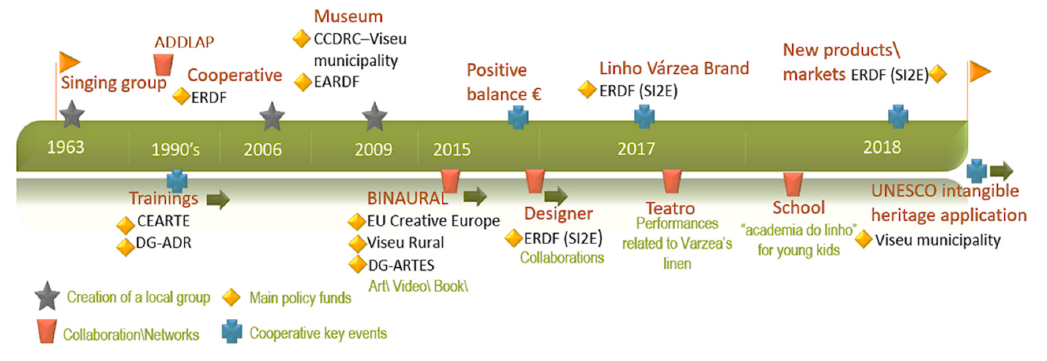
Figure 3. Timeline of developments around linen in Várzea.